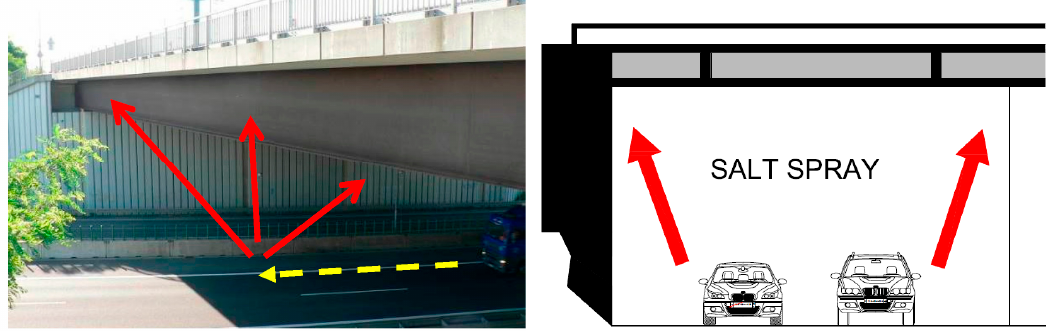
Figure 4. Bridge No. 1—Environment under the bridge is similar to the environment in the tunnels.